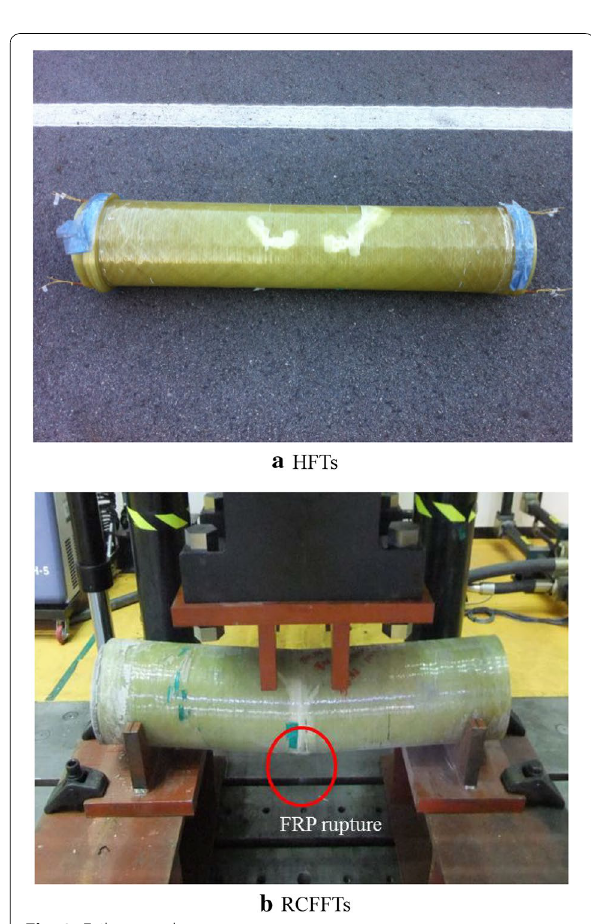
Fig. 8 Failure mode.